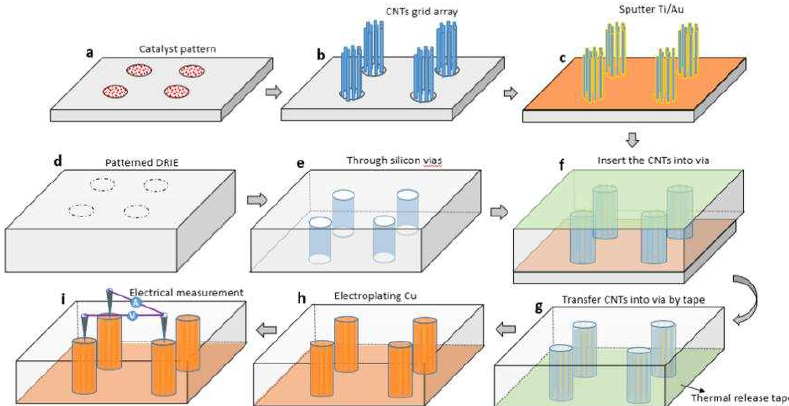
Figure 9. Process flow diagram of Cu-CNT TSV fabrication. ( a ) Patterned catalysts were deposited by E-beam evaporation. ( b ) A CNT grid array was synthesized by using CVD. ( c ) Sputtered 10 nm Ti and 20 nm Au onto the CNT grid array. ( d,e ) In parallel to these steps, the target Si wafer/chip with via was prepared by deep reactive ion etching (DRIE). ( f ) Thermal release tape was attached onto the front surface of the target wafer/chip and the CNT grid array were transferred into the via. ( g ) The donor wafer/chip was removed. ( h ) Cu was transferred into the vias by electroplating to form the composite CNT/Cu TSV and the adhesive tape was removed. ( i ) Electrical performance was characterized by the four probe method. Reprinted with permission from ref. [28]. Copyright